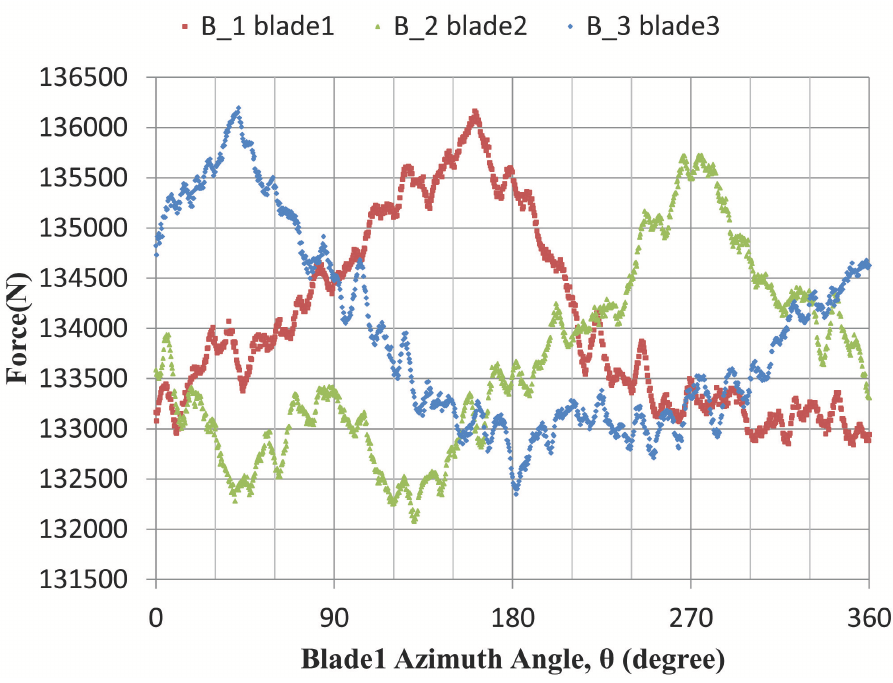
Figure 6. Axial forces imposed on blades versus the azimuth angle.